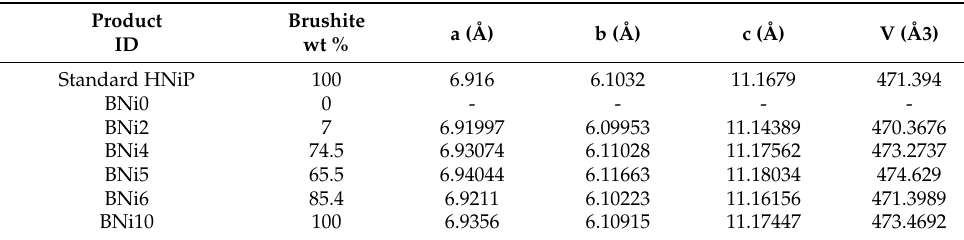
Table 3. The unit cell parameters for HNiP (product name BNi10) are derived from XRD scans (Rietveld refinement).